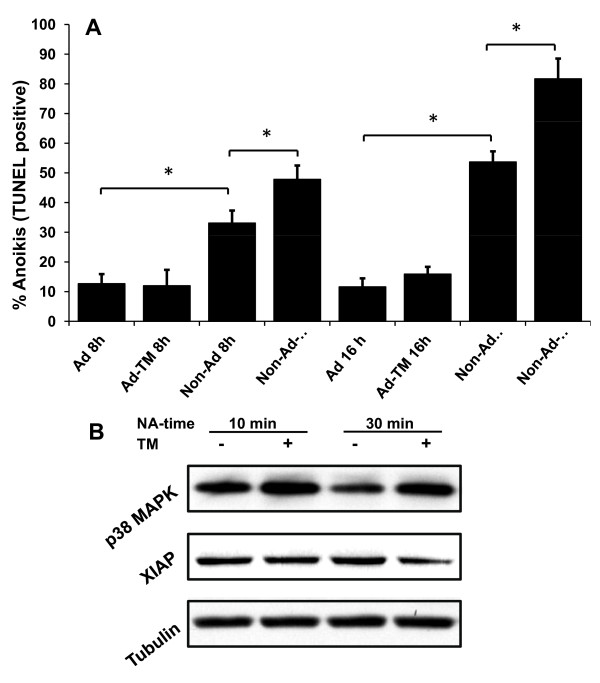
TM treatment significantly enhanced oral squamous cell anokis. A; OSCC-3 cells were cultured either in normal adherent conditions (Ad) or non-adherent conditions (Non-Ad) for different time intervals. At the end of incubation, cells were carefully retrieved and analyzed by TUNEL staining for anoikis using flow cytometry. * represents a significant difference (p < 0.05) as compared to the control group. B; OSCC-3 cells were cultured in non-adherent conditions for different time intervals. Whole cell lysates of untreated or TM treated OSCC-3 cells were separated using 4-12% NuPAGE Bis-Tris gels and probed with anti-phospho-p38MAPK, and XIAP antibody. Equal sample loading was verified by stripping the blots and re-probing with anti-tubulin antibody.